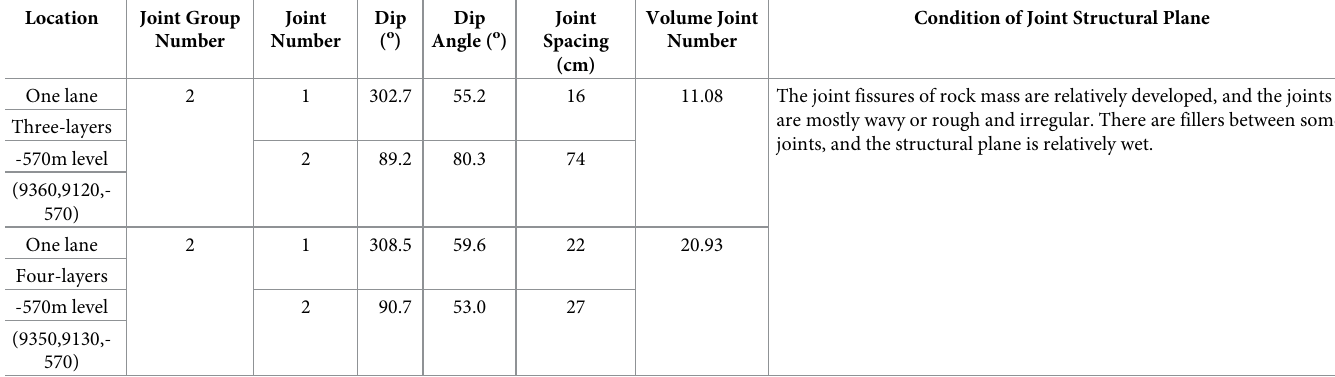
Fig 12. Schmitt diagram and rose diagram of joint in the -570m level (a) Schmitt diagram; (b) rose diagram. https://doi.org/10.1371/journal.pone.0283205.g012 It can be seen from the Fig 14 that the early curve of rock compressive strength is not smooth, indicating that the rock has joint cracks. During the loading process, the joint cracks weaken the bearing capacity of the rock, and the cement in the rock joint cracks affects the bearing capacity of the rock. There is a small peak curve before the peak strength of the stress- strain curve of the rock sample SZY-008, indicating that there are joints in the rock sample, and its failure strength cannot truly reflect the compressive strength of the rock itself. There- fore, the compressive strength of the rock is 140 MPa. There are many post-peak curves of SZY-012 sample, and it has obvious characteristic curves. After the sample passes the peak stress, its internal structure is destroyed, and the single sample basically maintains the whole shape. In the post-failure stage, the fractures develop rapidly, intersect and combine with each other to form macroscopic fracture surfaces. Since then, the deformation of the rock sample is mainly manifested as the block slip along the macroscopic fracture surface. The bearing capac- ity of the sample decreases sharply with the increase of deformation, but it does not drop to zero, indicating that the rock sample still has a certain bearing capacity after fracture, but Table 3. Structural plane information in the -570m